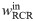
Effects on relay-cell spatial impulse-response function characteristics from excitatory and inhibitory inputs are opposite.Top row: dependence on the feedforward inhibition weight wRIG and width aRIG. Middle row: dependence on the feedback inhibition weight wRCRin and width aRCRin. Bottom row: dependence on the feedback excitation weight wRCRex and width aRCRex. All values are normalized with respect to the case where relay cells only receive feedforward excitation from retinal ganglion cells. The parameters in WG and KRG are kept fixed (see Table 1).